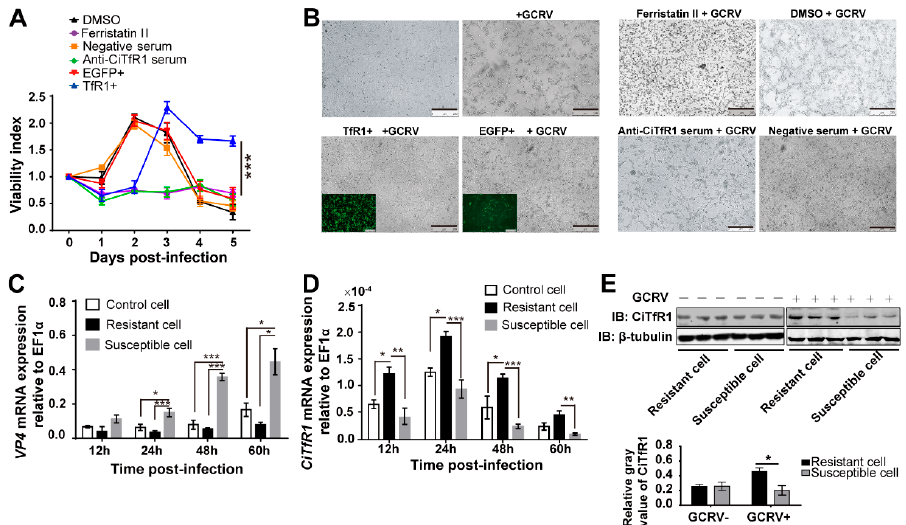
Figure 6. CiTfR1 plays a positive role in CIK cells against GCRV infection. ( A , B ) CiTfR1 increases the viability of CIK cells against GCRV infection. 1 % DMSO, 100 µ M Ferristatin II, 1% negative serum, or 1% anti-CiTfR1 serum treated CIK cells, EGFP+ cells, and TfR1+ cells were infected with GCRV (MOI = 1.5). At the indicated time points, the OD of each well was detected ( A ); At 24 h p.i., cells were imaged by using a fluorescence microscope, bar = 250 μ m ( B ). ( C , D ) Relative mRNA expression levels of VP4 ( C ) and CiTfR1 ( D ) in GCRV-infected control, GCRV-resistant, and GCRV-susceptible CIK cells. Three sorts of CIK cells (1 × 10 6 /sort) were equally seeded into 12-well plates. After 24 h cultivation, cells were infected with GCRV and then harvested at the indicated time points. ( E ) The protein levels of CiTfR1 in GCRV-susceptible and GCRV-resistant CIK cells treated with GCRV or PBS. The two sorts of CIK cells cultured in six-well plates were treated with GCRV or PBS and harvested for WB analysis at 12 h after the treatment. Data represent the mean ± SD of three independent experiments. * p < 0.05, ** p < 0.01, *** p <